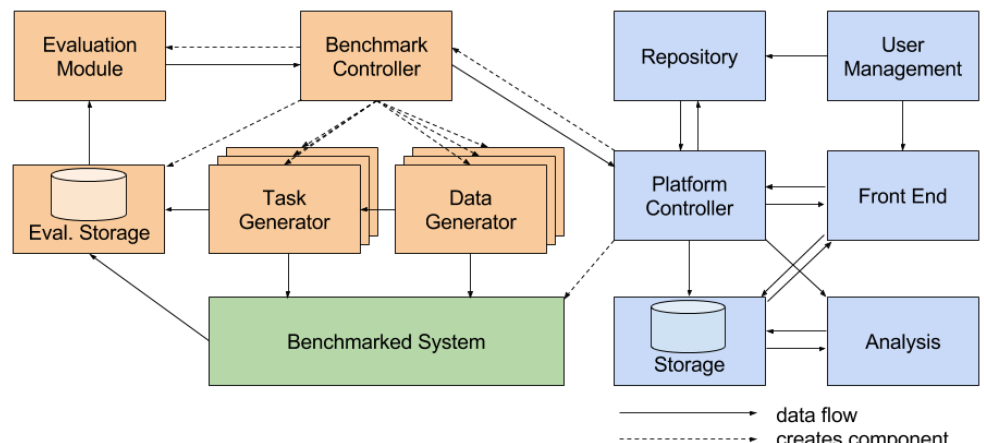
Figure 2. The HOBBIT benchmarking platform.